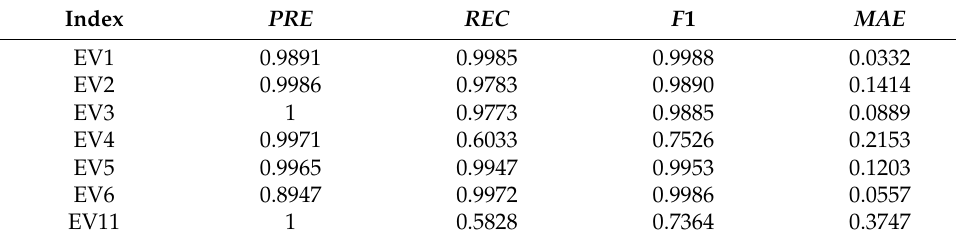
Table 3. NILM analysis results of EV charging stations after adding EV11.